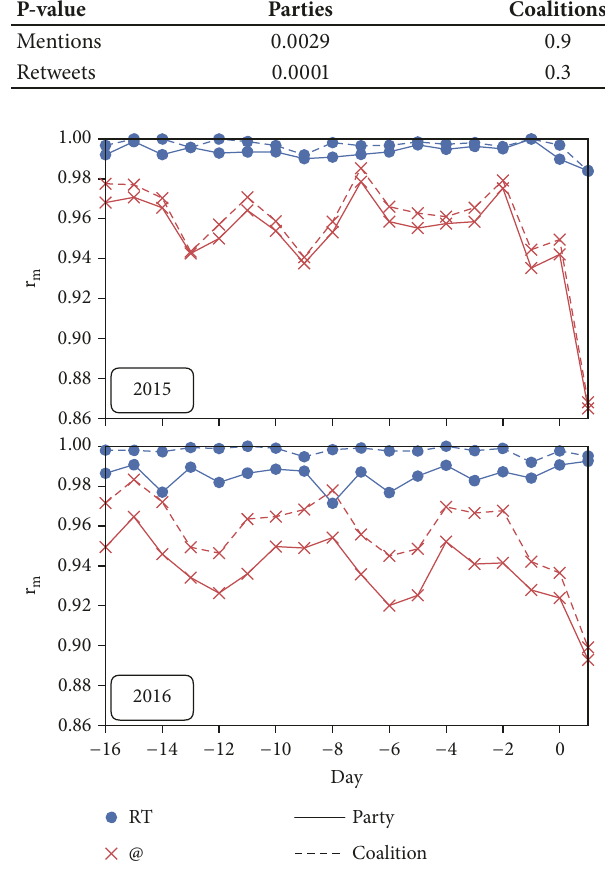
Figure 11: Daily evolution of the assortative mixing by party and coalition for the mention (@) and retweet (RT) networks in 2015 (top) and 2016 (bottom) electoral